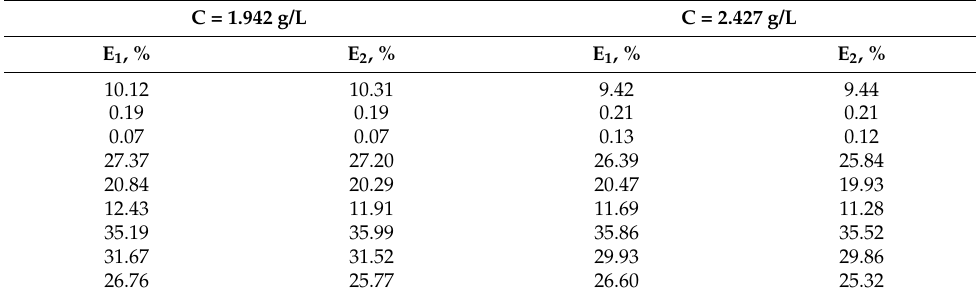
Table A1. Comparison or extraction ratios (E) of caffeine in CO 2 –water–PEG-1500 system obtained via: (1) at-line SFC analysis of CO 2 -rich phase and subsequent calculation using mass balance (E 1 ), and (2) direct offline analysis of a sample of water-polymer phase after extraction (E 2